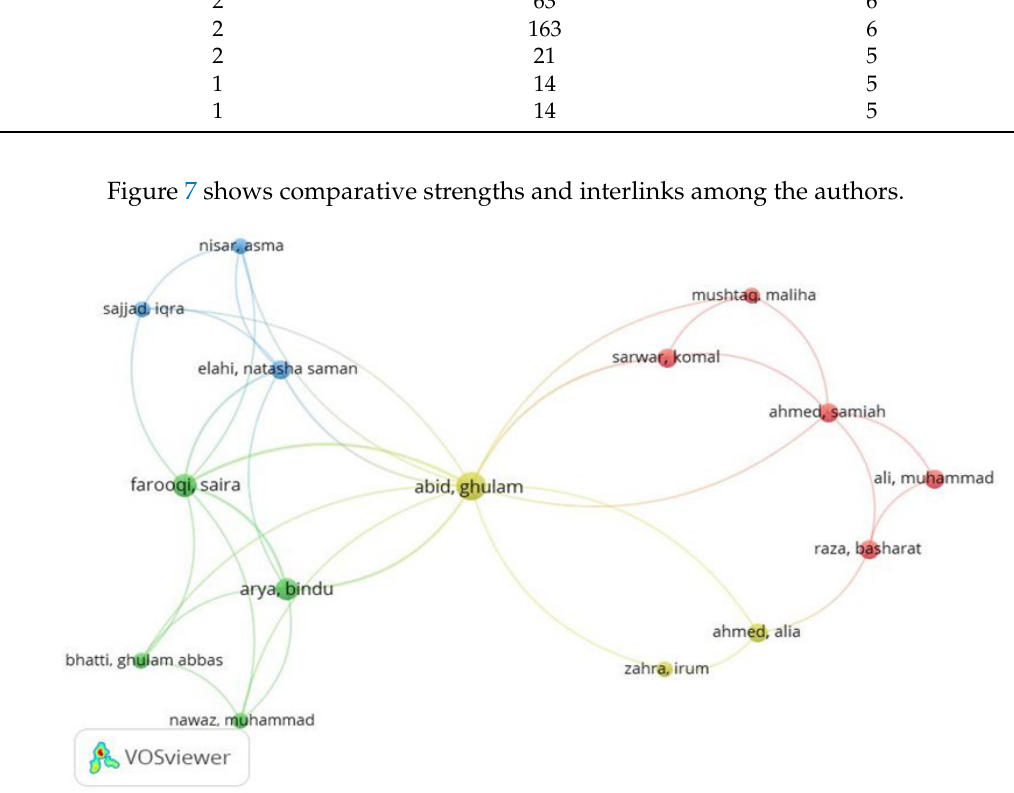
Figure 7. The total strength of co-authorship links between the 15 authors is highly connected with other authors.